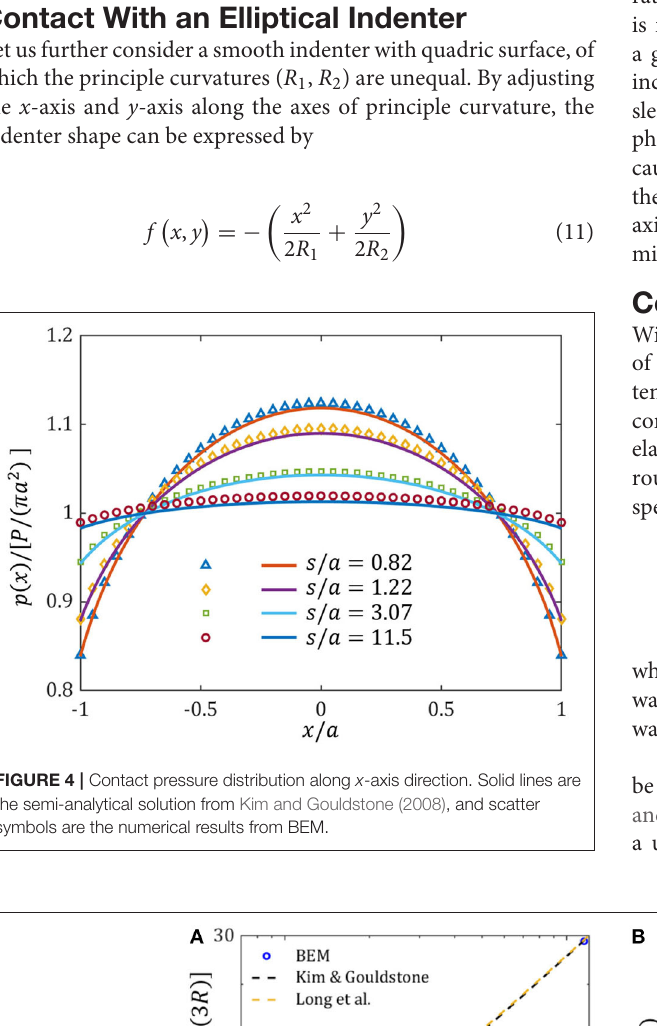
Frontiers in Mechanical Engineering |